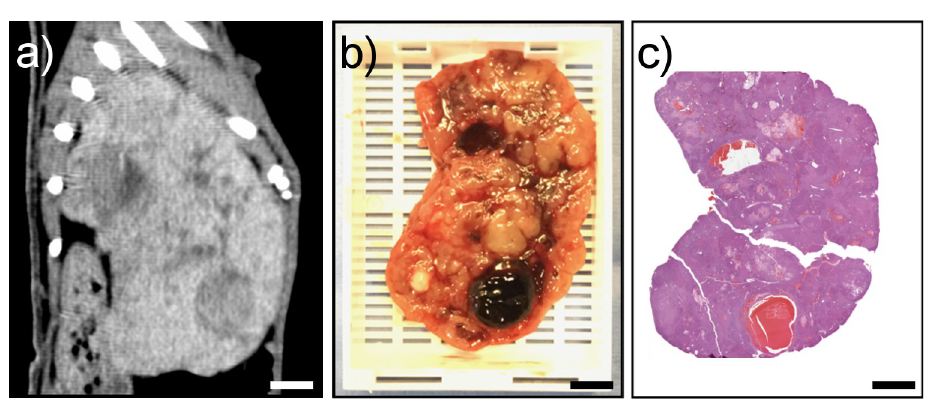
Fig 5. Corresponding in vivo CT imaging, gross pathology, and histopathology of a specimen cut without fixation. (A) CT slice in sagittal plane corresponding to gross- and histo-pathology tumor specimens in B and C. (B) Unfixed 5 mm thick gross pathology specimen from the mold. (C) Histopathology section stained with H&E. Scale bars represent 1